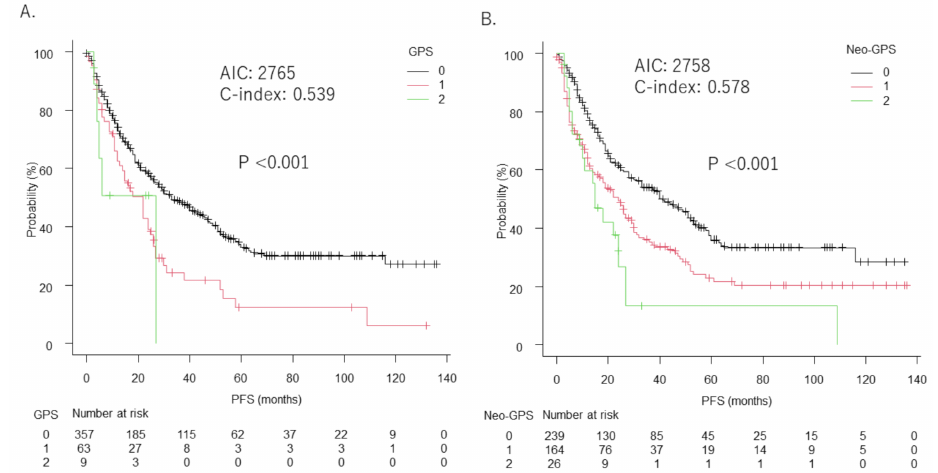
Figure 2. Comparison between GPS and neo-GPS for prediction of progression-free survival